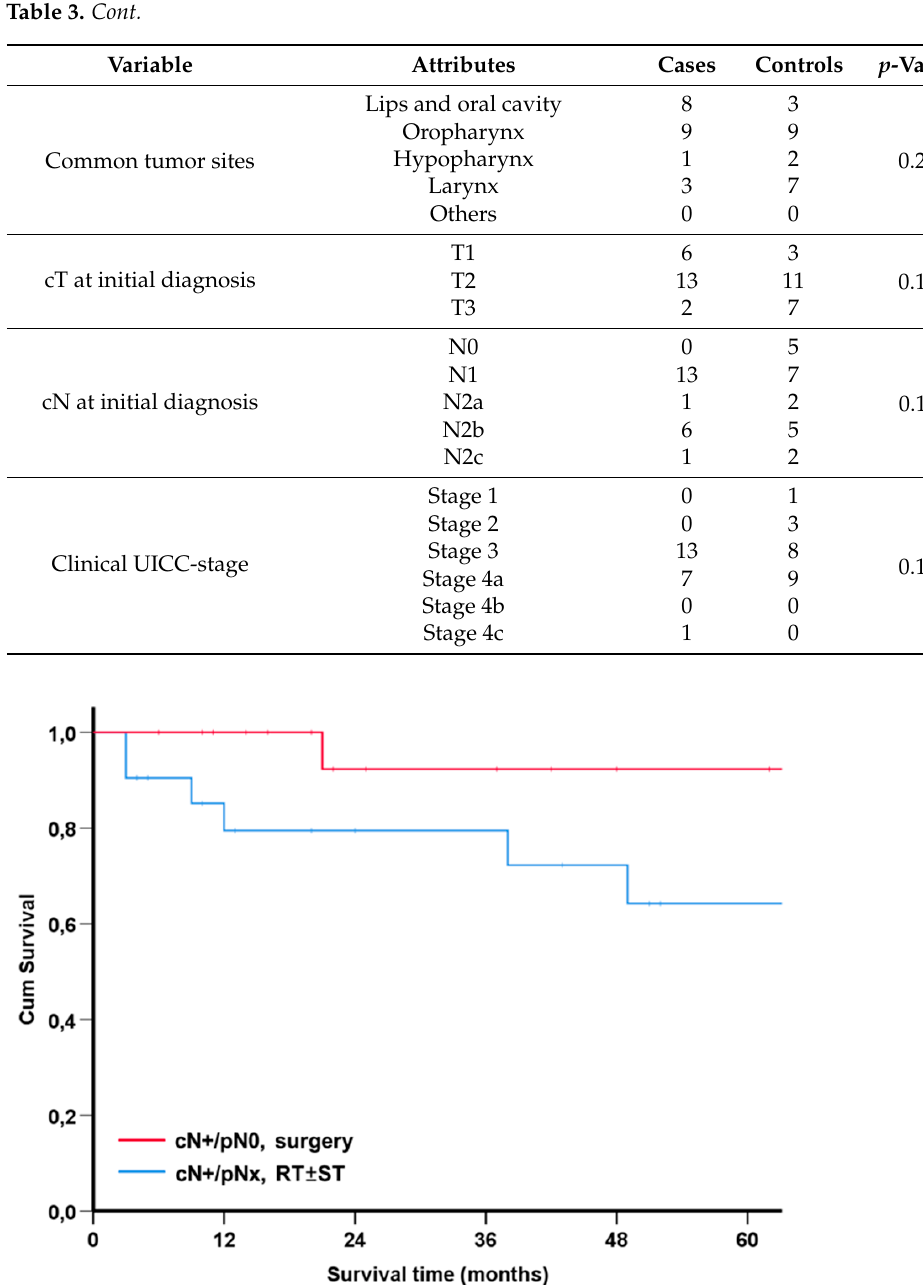
Figure 3. Kaplan–Meier plots of 21 patients with originally planned surgical tumor resection, thera- peutic neck dissection and PORT (red line), in whom treatment was finally de-escalated to surgery alone (cases), and matching patients with cN+ (blue line) who were admitted to definitive primary RT ± ST (controls; n = 21; log rank p = 0.18). Functional integrity was better in the surgically treated cN+ patients with treatment de-escalation. Significantly more surgical patients reported better nutritional function than matched patients with RT ± ST ( p = 0.002), while the other outcome parameters showed no differences (Table